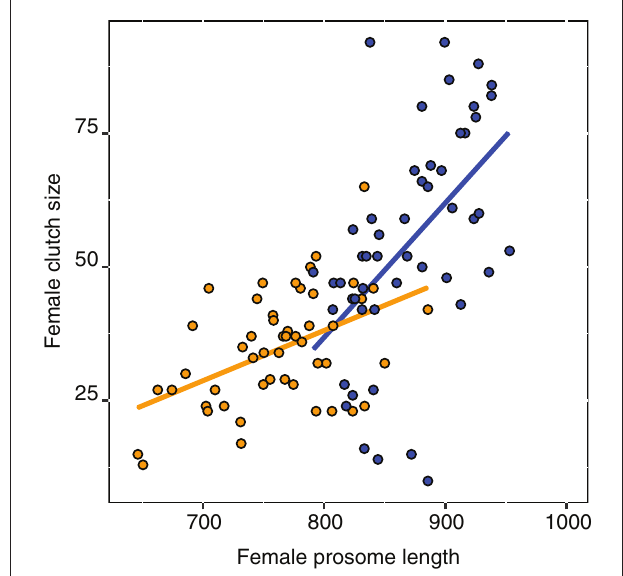
FIGURE 3 | Relationship of female clutch sizes and prosome lengths for the STHLM (orange) and GOR (blue) E. affinis populations. Points are observed values and lines are fitted values from a two-way analysis of